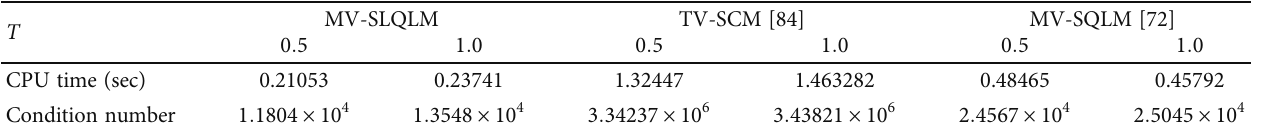
Table 3: Comparing running time and matrix coe ffi cient condition number of the proposed method and the TV-SCM [84] and MV-SQLM [72] for problem, equations (10) – (13) and (19); N